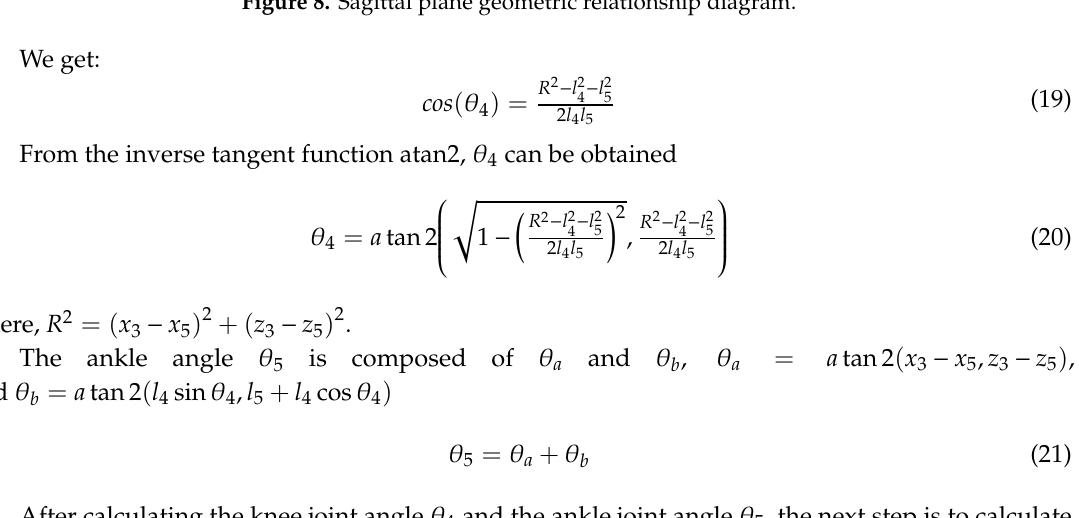
Figure 8. Sagittal plane geometric relationship diagram.